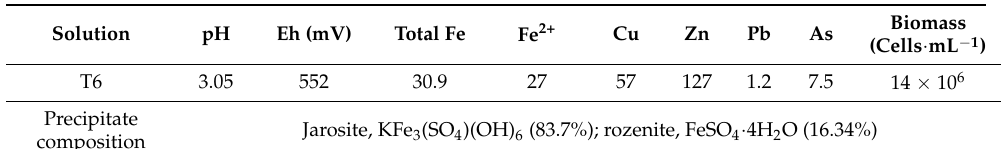
Table 2. Certain characteristics of the remnant solution T6 and the precipitate formed at the bottom of the containers. Metal concentrations are given in grams per liter (g · L − 1 ).